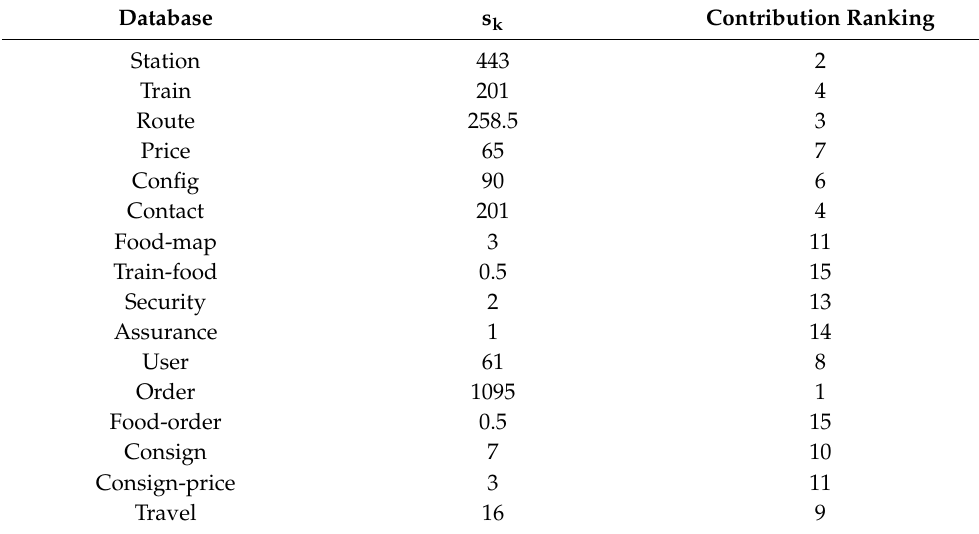
Table 16. s k and contribution ranking of databases in